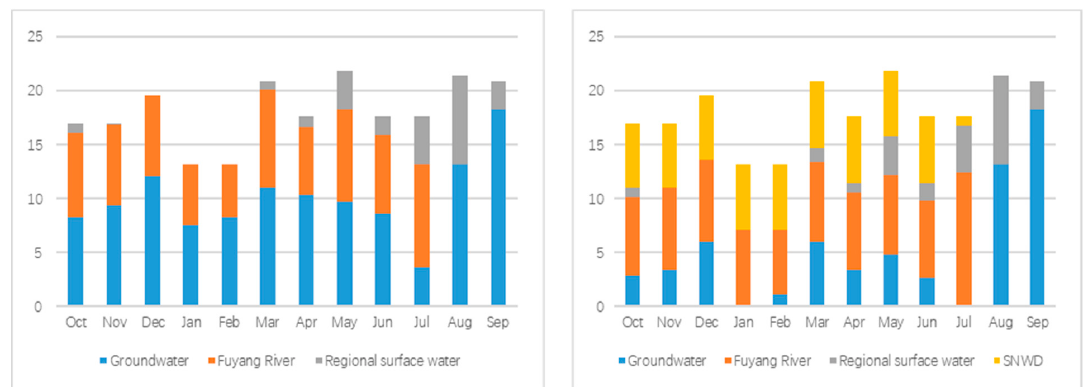
Figure 3. Monthly water use in a normal year of Cheng’an (Unit 10 6 m 3 ).